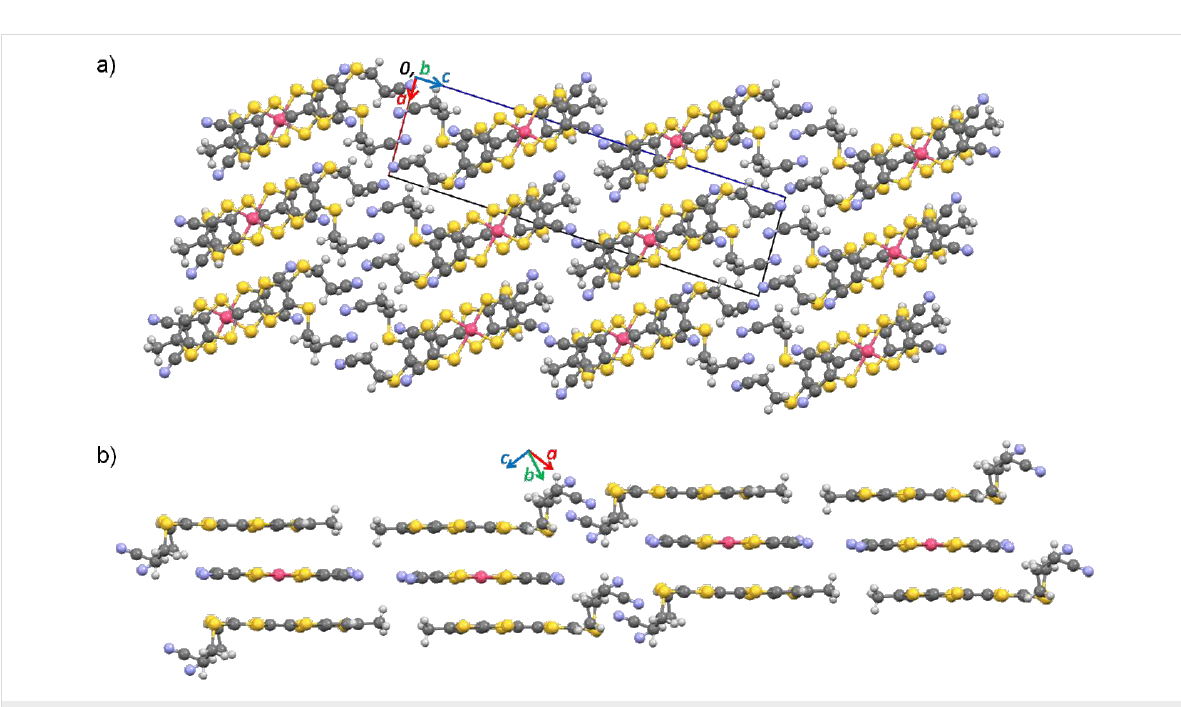
Figure 7: ORTEP views and atomic numbering scheme of a) ( α -mtdt) + and b) [Au(mnt) 2 ] − in compound 3 , with thermal ellipsoids at 50% probability level.